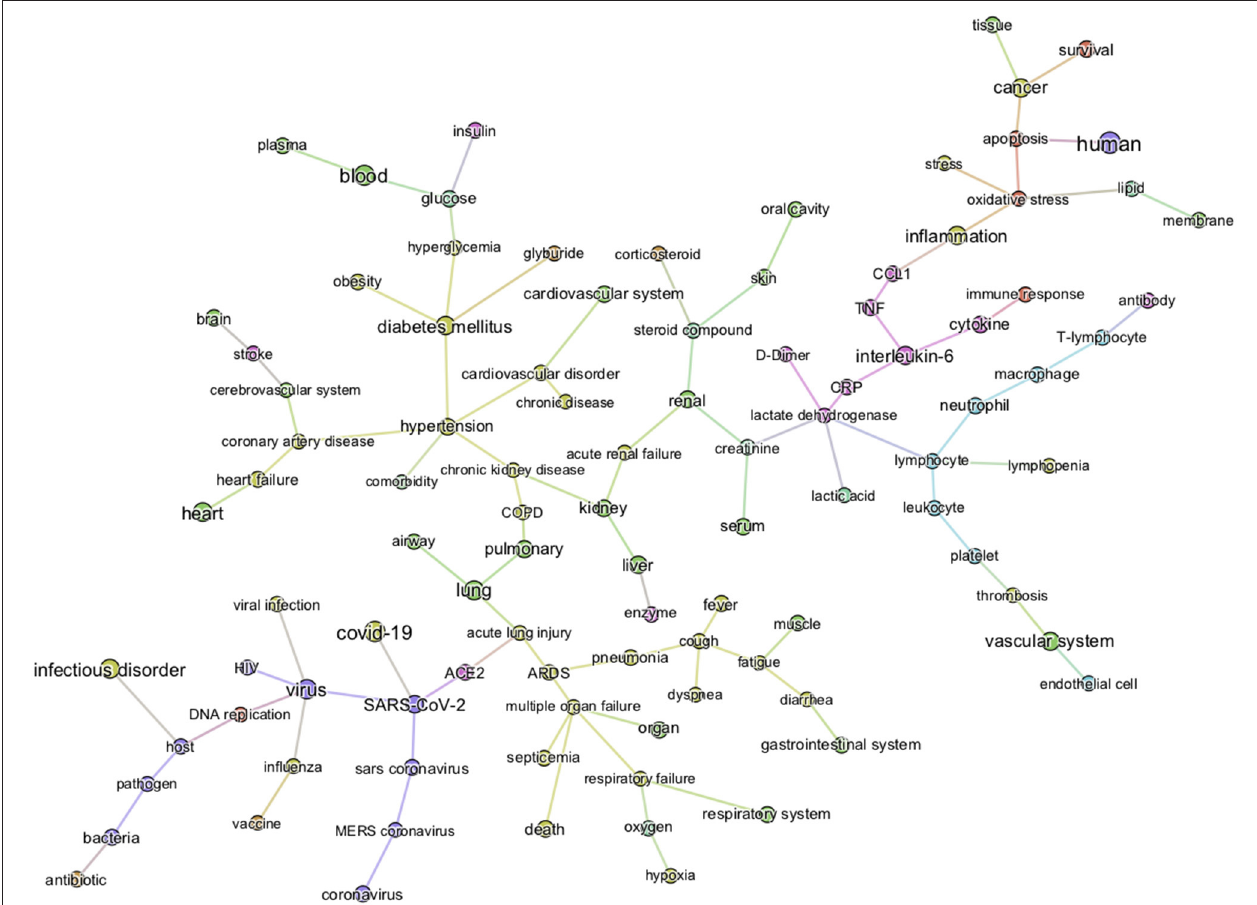
FIGURE 4 | Minimum spanning-tree constructed from the knowledge subgraph containing the 150 most frequently mentioned entities. The knowledge graph is built from the 3,000 most relevant articles related to the query “glucose as a risk factor for COVID-19” as detailed in methods. The spanning tree is obtained by minimizing an edge distance score based on mutual information (see section Methods). The entity types are color-coded as presented in Figure 2 . Such sparsified view of the knowledge graph allows us to get insight on the most frequent entities linking glucose (top left) to various aspects of the disease in the CORD-19. For example, the term “hyperglycemia” provides an important link between glucose and all risk groups for COVID-19 (i.e., DM, obesity, hypertension, and cardiovascular disorder). It also illustrates that the literature supports a strong association of glucose-related terms to immune responses, inflammatory processes, vascular system, thromboses or airways of the